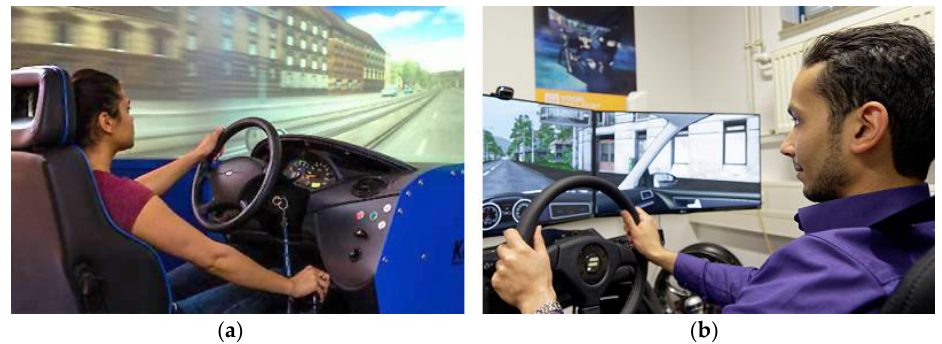
Figure 1. Utilization of driving simulators in driving schools in Germany: ( a ) Driving simulator at the Ringhoff driving school; ( b ) Driving simulator at the Hainer driving school. Ringhoff driving school; ( b ) Driving simulator at the Hainer driving